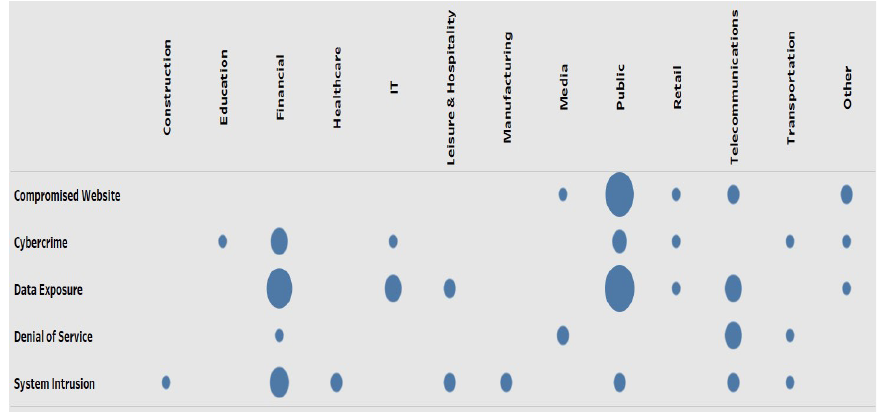
Figure 7: Sector affected per cyber incident type,